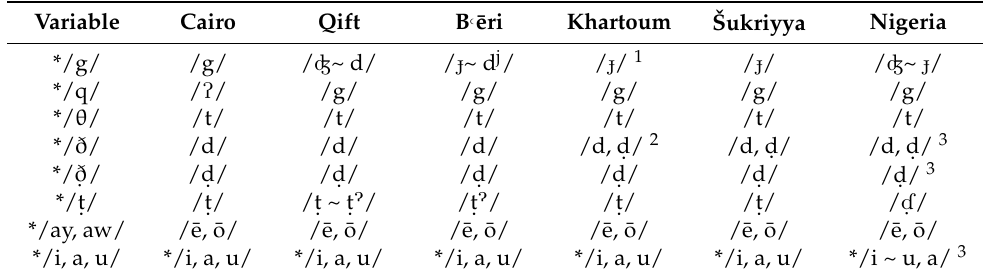
Table 1. Segmental